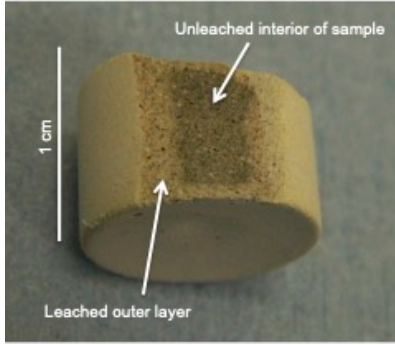
Figure 1 . Leached 242 Pu containing cement pellet (12 mm diameter), showing the altered leached layer around the darker, unaltered unleached interior.